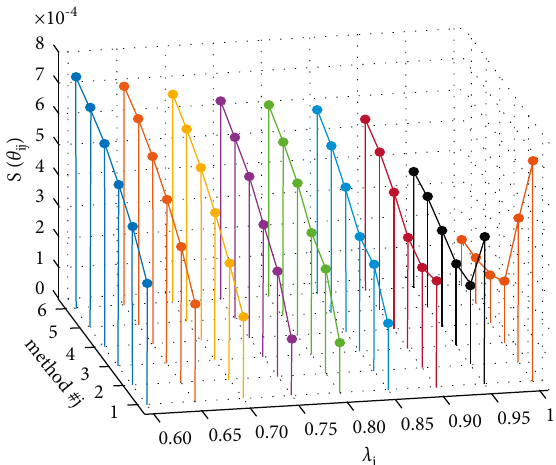
Figure 8: Model performance index values S ( θ FFOPDTmodels with parameters θ ij , obtained for each process P 1,i ( i � 1, ... , 9) using methods # j ( j � 1, ... , 6).